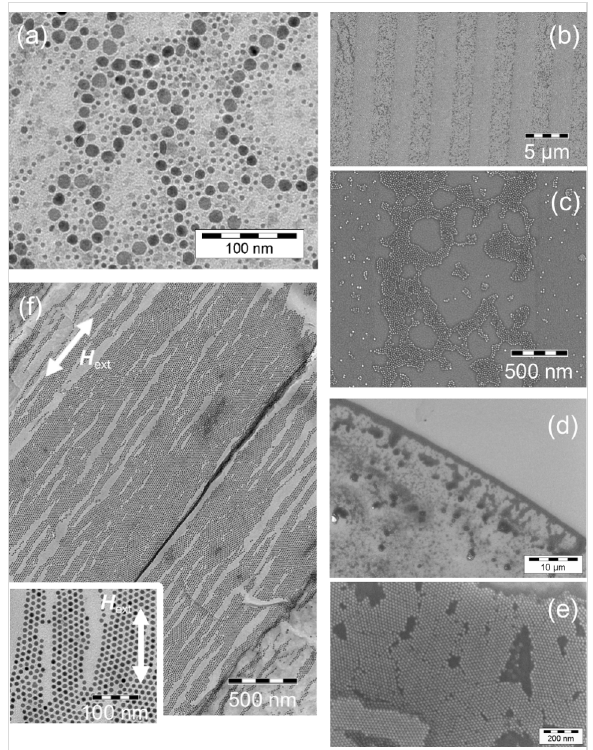
Figure 10: Images of self-assembled spherical Co nanoparticles: (a) TEM image of a bimodal distribution; large particles with a diameter of about 12 nm are ferromagnetic and assemble in ring-shaped super- structures. (b) Influence of the surface properties on the self-assembly; Co particles are predominately arranged along areas which were previ- ously covered with photo resist and (c) detailed image of the particle ordering. (d) SEM images of assemblies under the combined influ- ence of hydrodynamic and capillary forces; the edge of the drop mainly consists of a particle monolayer. (e) Detailed image of the hexagonal network formed by the particles within the monolayer. (f) Particles deposited under the influence of an external magnetic field. The nanocrystals are organized in lines oriented parallel to the direction of the applied field. The inset shows a detailed image of the distorted hexagonal